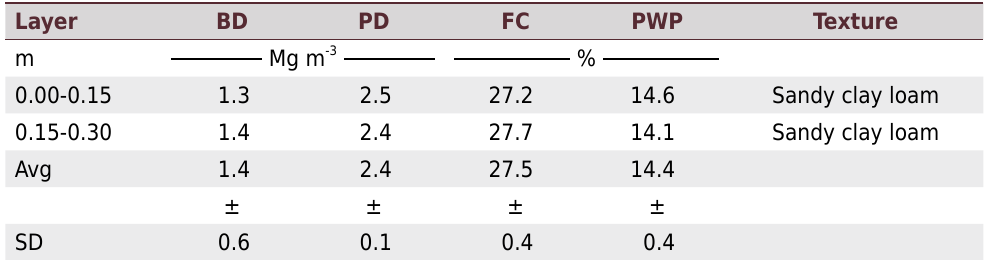
Table 2. Physical properties of soil samples from the Comarca Lagunera,